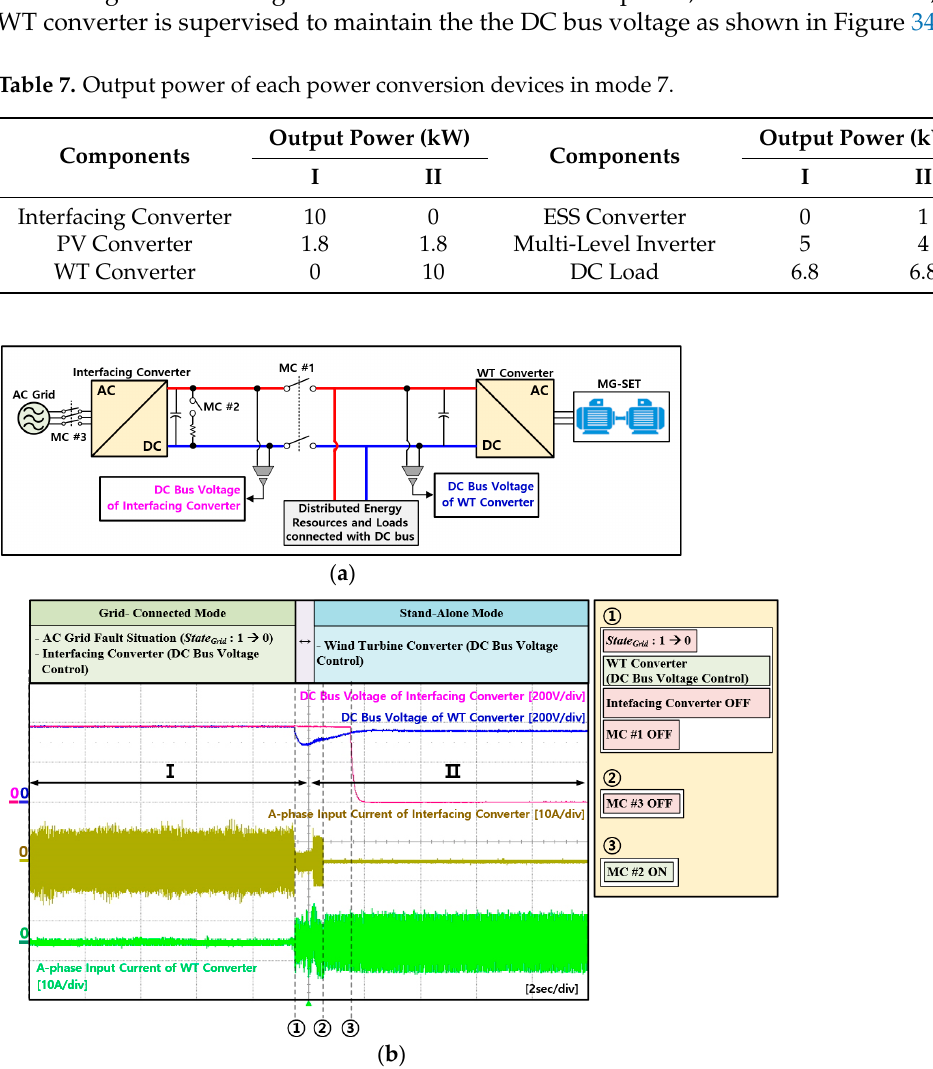
Figure 33. Experiment waveforms of PV converter and ESS converter in mode 6